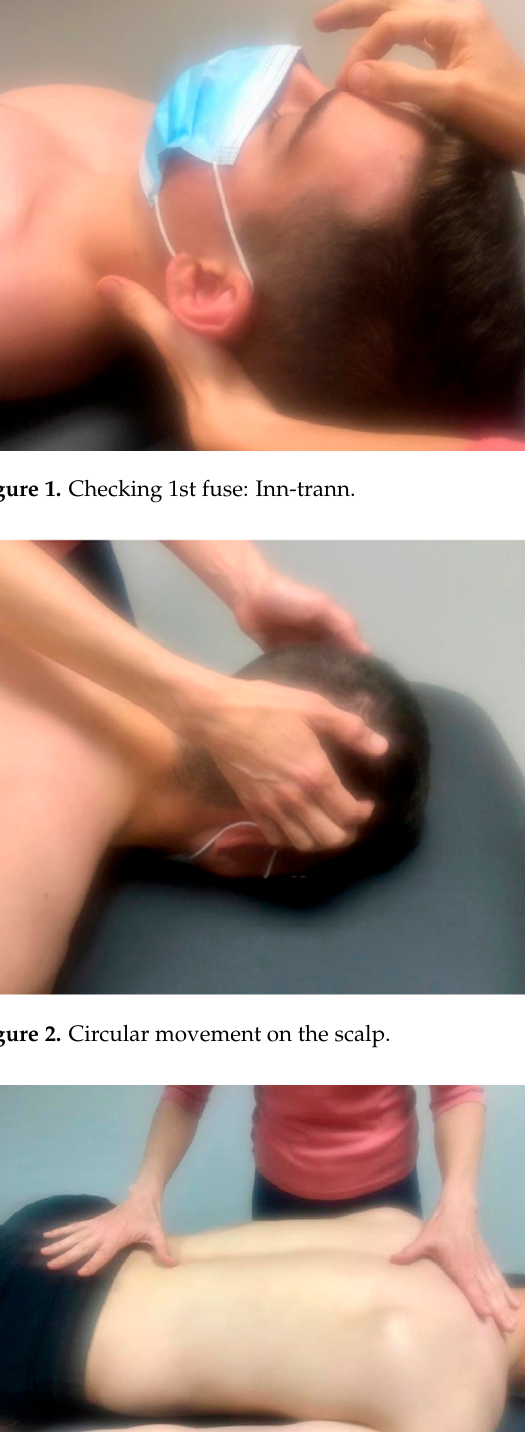
Figure 3. Checking cranio-caudal movement.